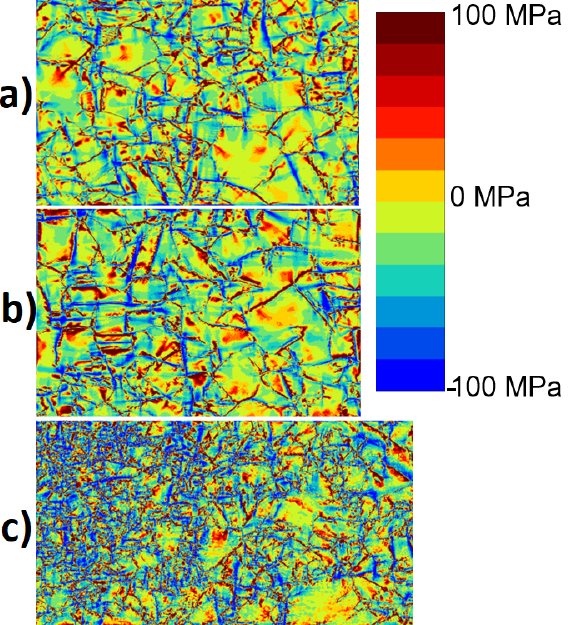
Figure 6. Generalized stress S χ at 10% of strain for microstructures ( a ) A, ( b ) B ( c ) welded. As the future scope of work, the model could be used to regularize creep related strain accumulation at the level of microstructure. The assessment of length-scale dependent damage [27] is also a topic requiring attention to improve the estimations of long-term deformation behavior of the copper material and overpack in the final disposal